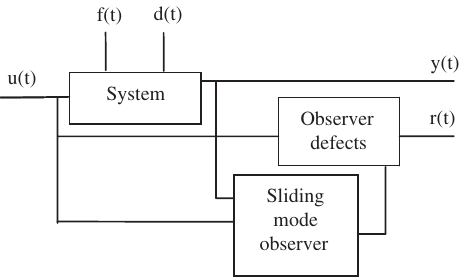
Figure 2. Principle of the Method based on the Sliding-mode Observer, Proposed for Residual